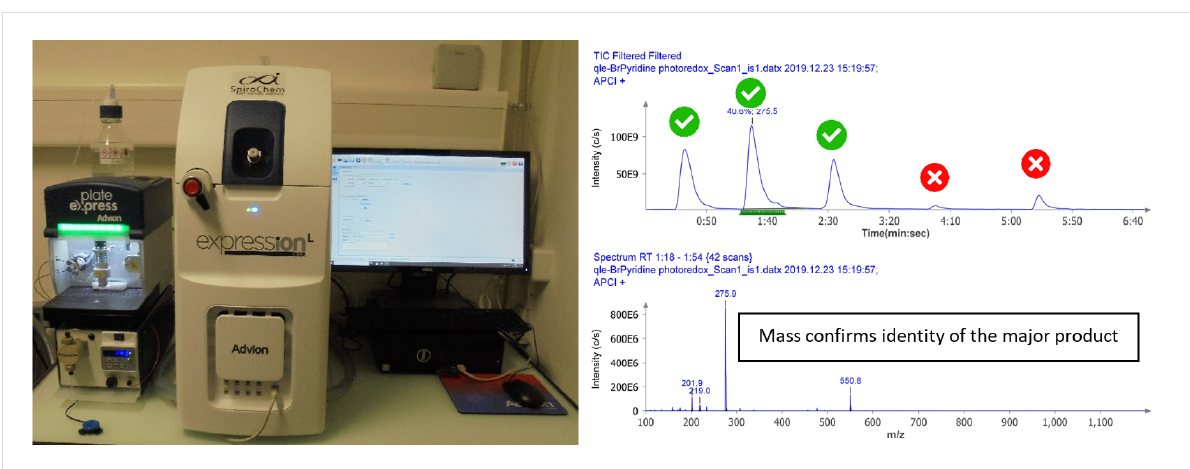
Figure 2: TLC–MS equipment: analysis of 5 reactions in 5 minutes.